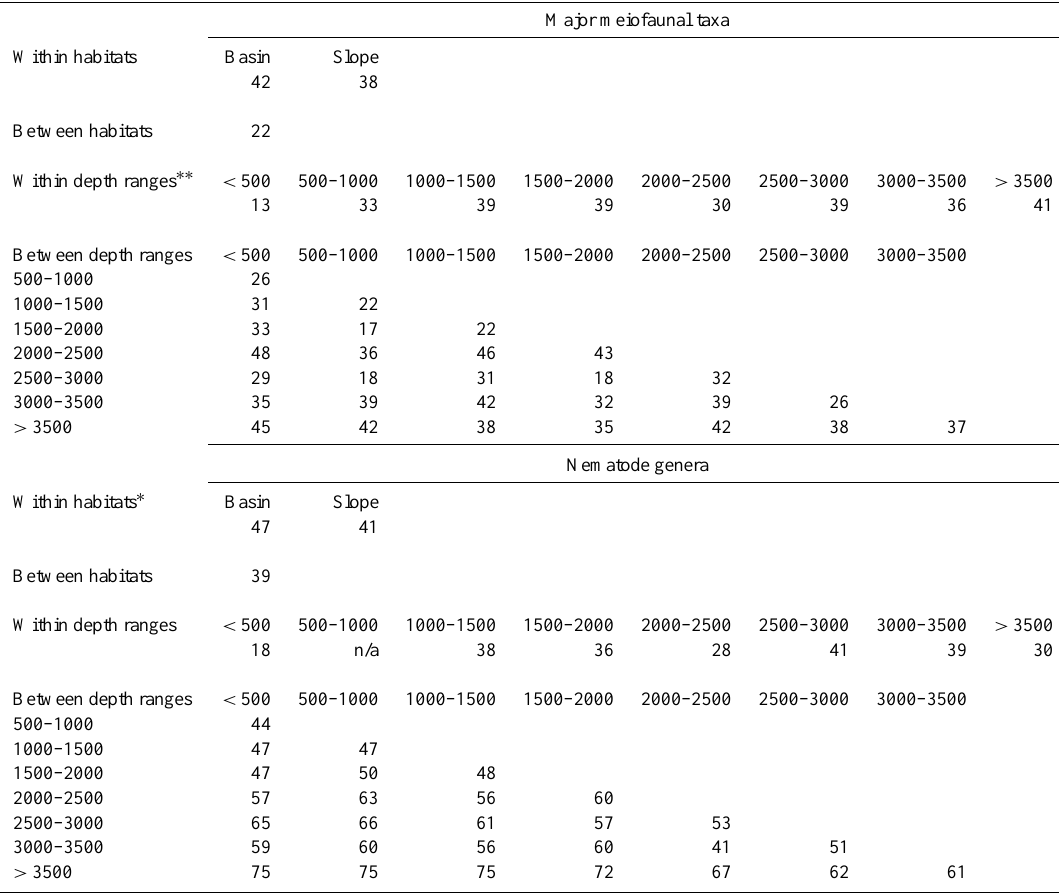
Table 3. Delta diversity of major meiofaunal taxa and of nematode genera based on Jaccard dissimilarity. Values within each habitat and within each depth range were calculated using multivariate dispersion. Dissimilarity increases from 0 to 100. Major meiofaunal